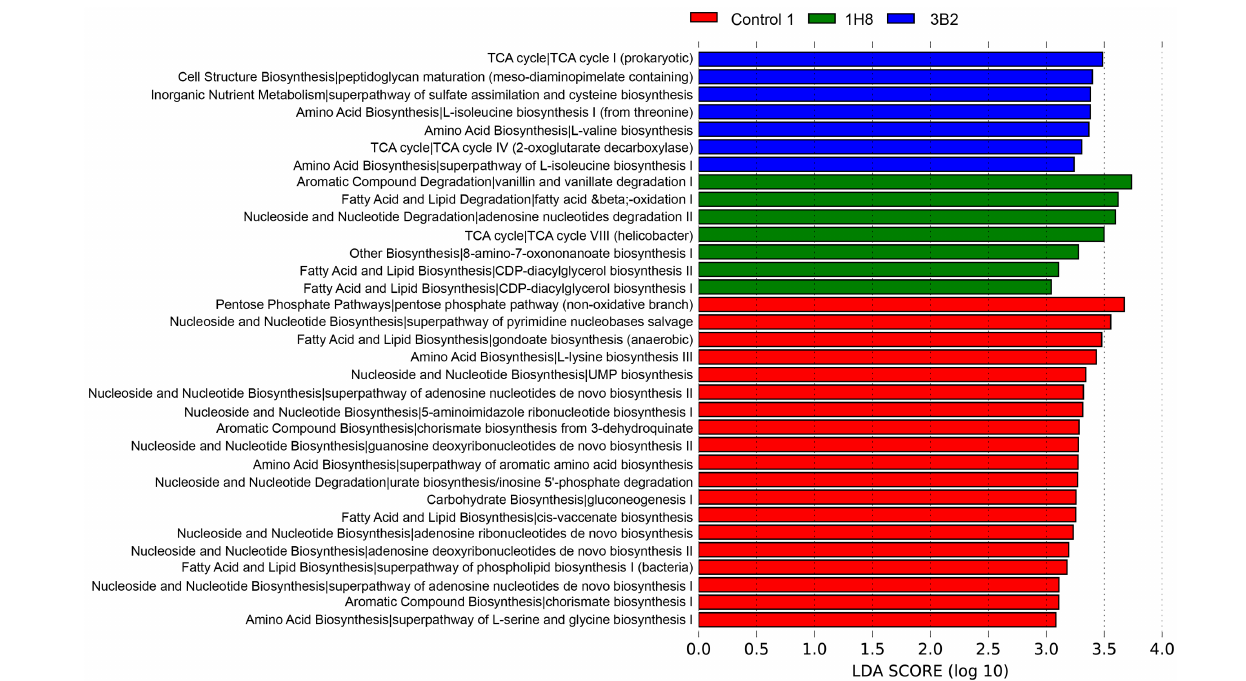
FIGURE 5 | Significantly different bacterial metabolic pathway in cigar tobacco leaves with different